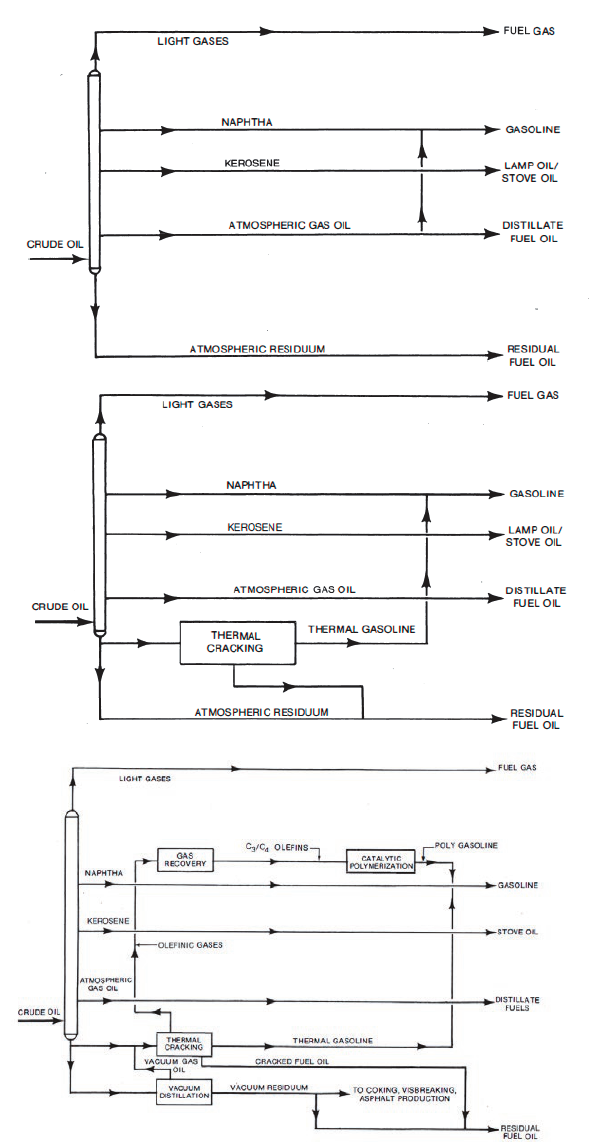
Figure 1. Refinery Configuration Evolution in 1915, 1920 and 1930. Reproduced from U.S. Petroleum Refining: Meeting Requirements for Cleaner fuels and Refineries. Appendix C. History and Fundamentals of Refining Operations, National Petroleum Council, 1993